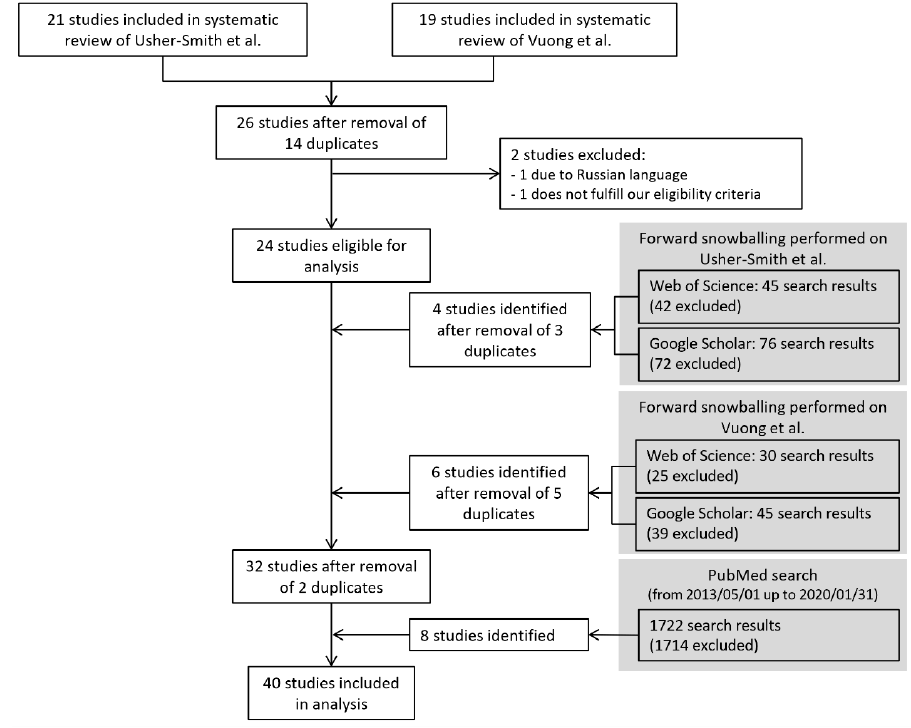
Figure1. Flowdiagram forthe identification ofstudies developingriskpredictionmodels Figure 1. Flow diagram for the identification of studies developing risk prediction models for melanoma.